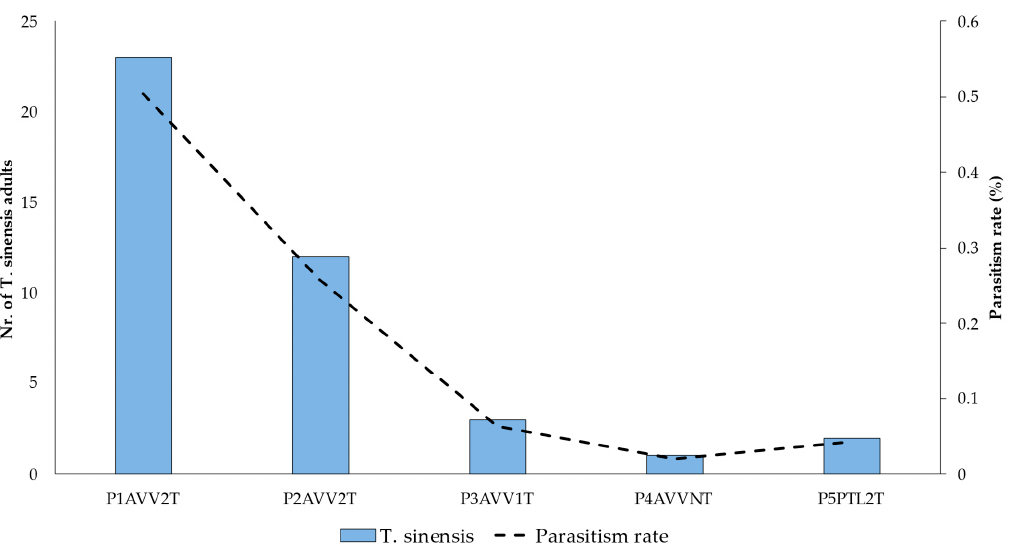
Figure 9. T. sinensis parasitism rate and the number of adults emerged between February and March 2019 in the five chestnut orchards of Minho (P1 to P5), located in Arcos de Valdevez (AVV) and Ponte de Lima (PTL), with one (1T), two (2T) or no treatment (NT) of T. sinensis .